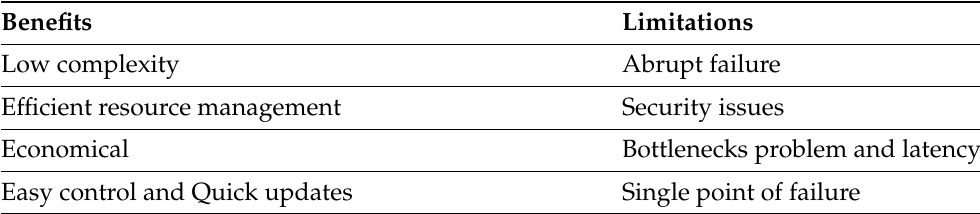
Table 4. Centralized architecture: Benefits vs.